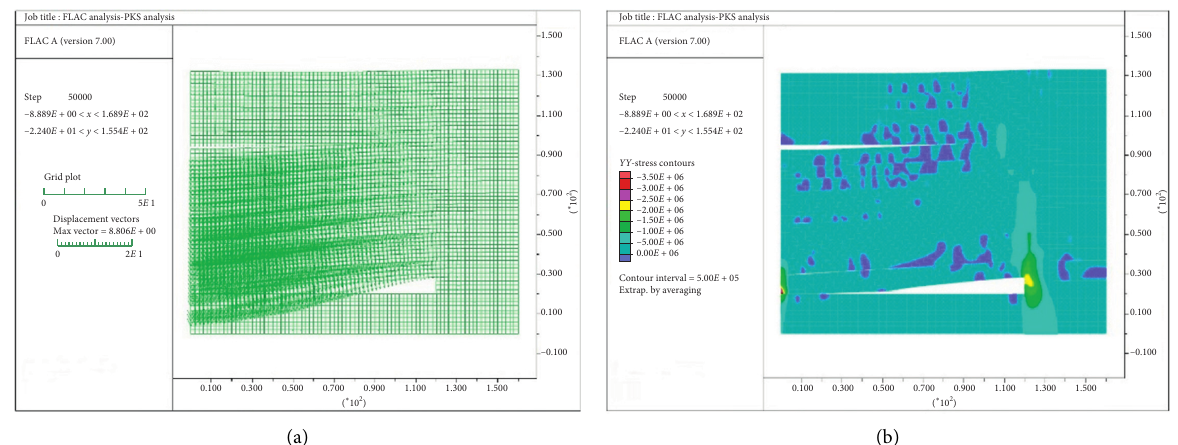
Figure 4: (a) Displacement vector and (b) plastic deformation of overlying strata.